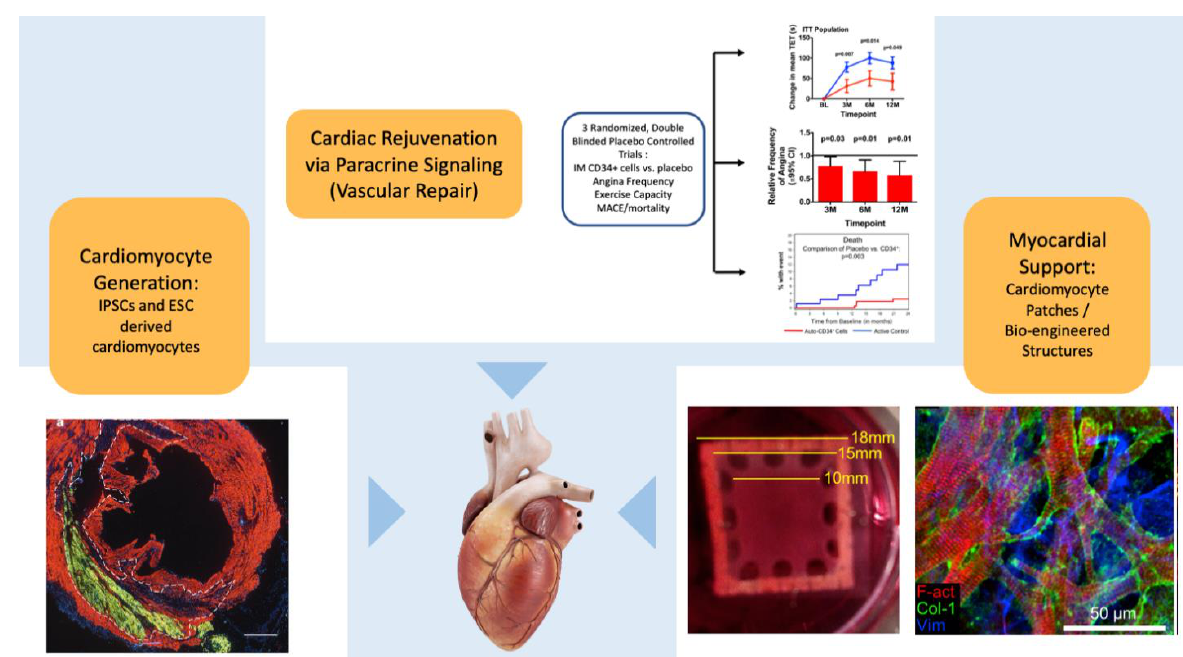
Figure 2. Future Approaches for Cardiac Regeneration/Rejuvenation: Top: Use of selected cells to enhance myocardial repair and rejuvenation to enhance vascular repair, reduce microvascular dysfunction, exert anti-inflammatory effects, and improve cellular function via paracrine effects. As one example, CD34 + cells may have significant clinical effects in patients with refractory angina even in the absence of myocardial generation [69]. Lower right: Confluence of bioengineering/cell therapeutic approaches to construct patches which may promote regeneration through direct mechanical and paracrine mechanisms. The left figure shows a 12-day patch of rat cardiomyocytes, the right panel shows staining for f-actin (red), collagen (green), and vimentin (purple). Adapted with permission from Jackman et al, Biomaterials, 159: 48-58 (2018). Lower left: Pluripotent stem cell sources such as cardiomyocytes derived from embryonic stem cells can permanently engraft and proliferate in the heart (green staining demonstrates green fluorescent protein expressing cardiomyocytes in non-human primate infarct model (Macaque monkey) at day 14). Adapted with permission [133] .